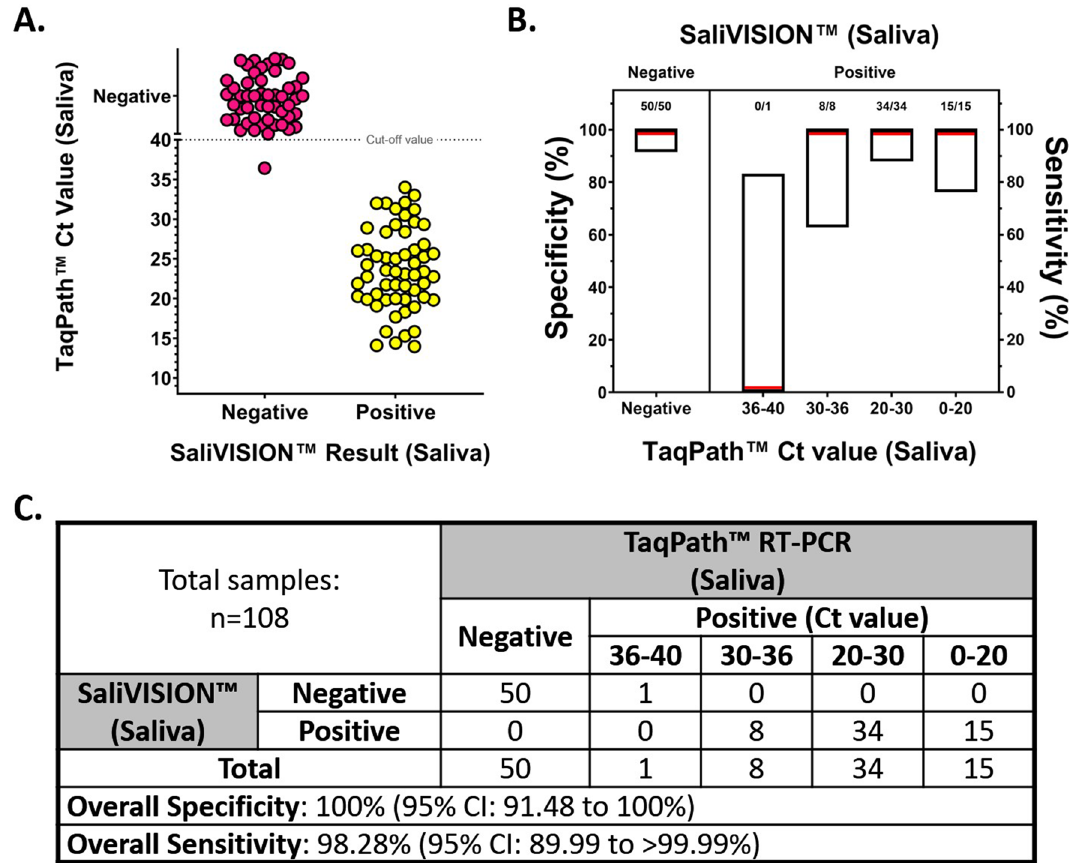
Figure 4. Clinical Validation of SaliVISION, Tested Side-by-Side with TaqPath, Using Saliva Samples. Saliva samples being collected for clinical diagnostic test by the Yale Pathology Labs were subjected to SARS-CoV-2 detection using SaliVISION (RT-LAMP) and Thermo Fisher Scientific TaqPath (RT-qPCR) methods. In both methods, saliva samples were treated with the lysis buffer and heat-inactivated before being processed. The results of RT-LAMP are compared to relative Ct value determined by quantitative TaqPath RT-qPCR test. ( A ) The figure represents the distribution of negative (pink) and positive (yellow) samples detected by the SaliVISION test according to their corresponding Ct value detected by the TaqPath test (Y axis). The dotted line indicates the cut-off value for SalivaDirect test, in which the samples with Ct value > 40 is considered negative and that with Ct value ≤ 40 is considered positive. ( B ) Specificity (left) and sensitivity (right) of the SaliVISION RT-LAMP assay, derived from data in 4A and C, are shown. For sensitivity, the RT-qPCR positive samples were stratified into four groups, based on the Ct value (x axis). The red lines indicate the value of these proportions. The floating boxes indicate the corresponding 95% confidence intervals computed by Wald’s method. ( C )